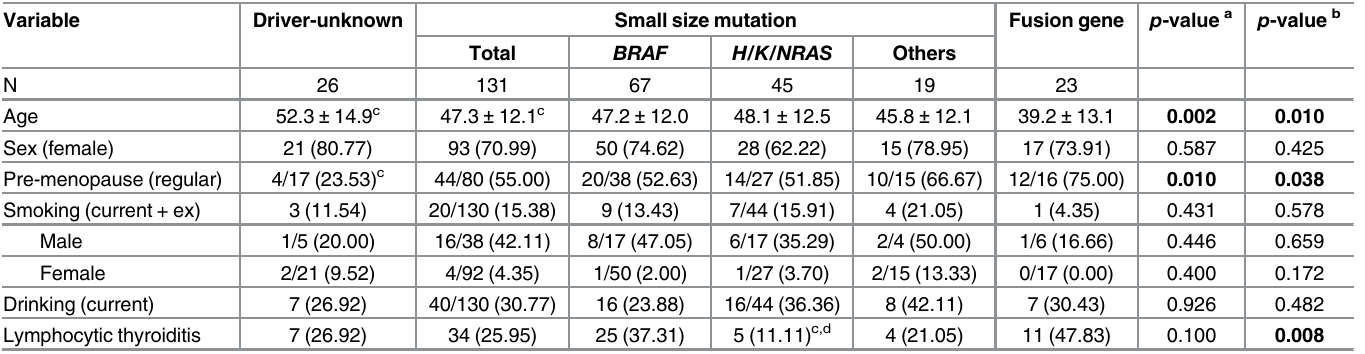
a p -value for comparison among Driver-unknown, Total, and Fusion gene mutation groups. b p -value for comparison among Driver-unknown, BRAF , H/K/NRAS , Others, and Fusion gene mutation groups. c Signi fi cantly different from “ Fusion gene mutation ” group. ( p < 0.05 for post-hoc Bonferroni test) d Signi fi cantly different from “ BRAF ” group. ( p = 0.002 for post-hoc Bonferroni